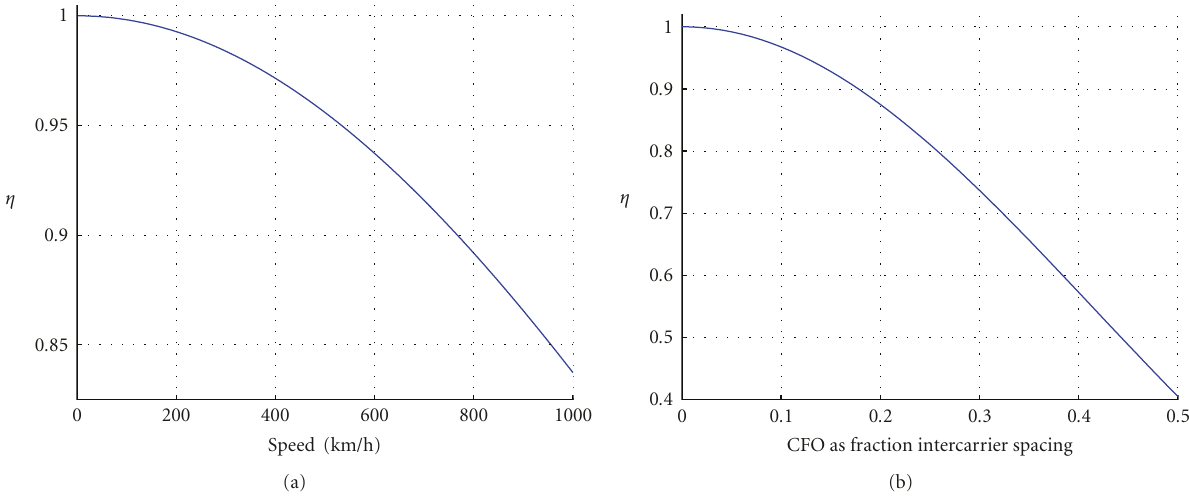
Figure 1: Fraction of energy retained by a subcarrier as (a) mobile’s speed increases and (b) as carrier frequency o ff set increases. The remaining energy is lost as intercarrier interference. System parameters: 512 subcarriers, 5MHz bandwidth, 3.5 GHz carrier